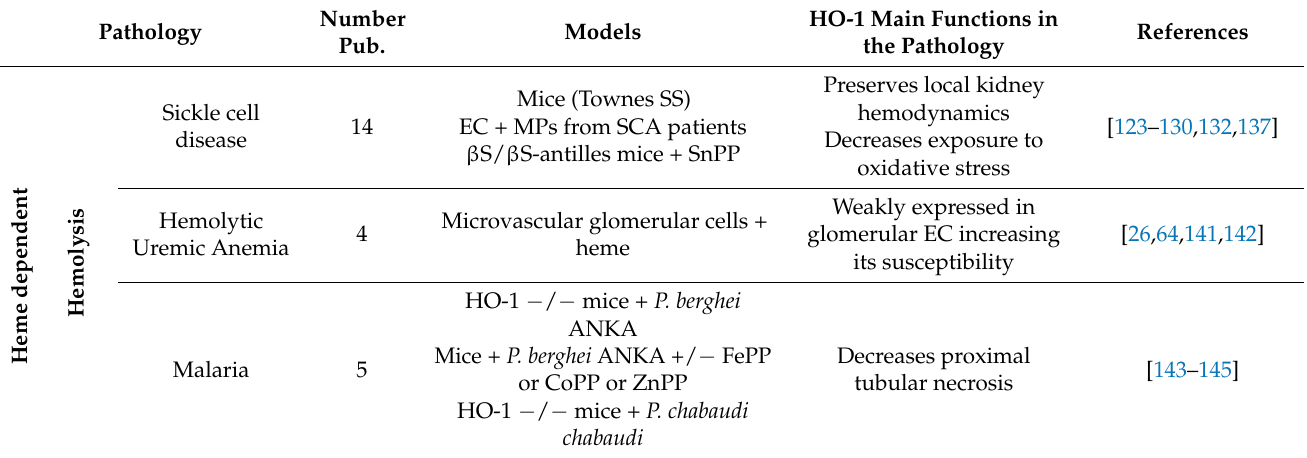
Table 1. Main models and functions of HO-1 in kidney